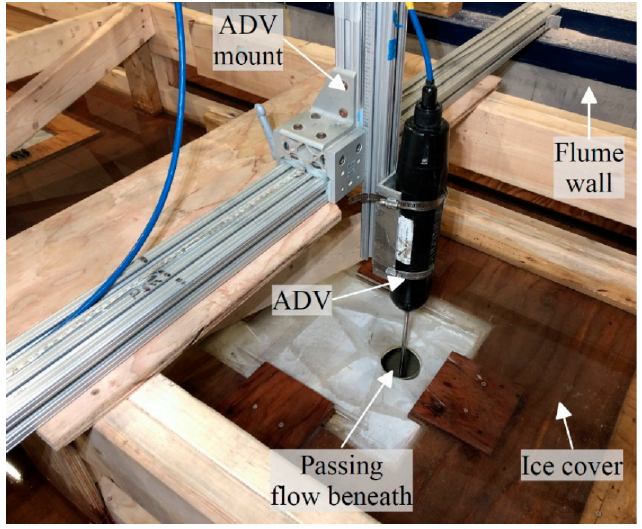
Figure 5. ADV setup with side-looking head protruding through the ice